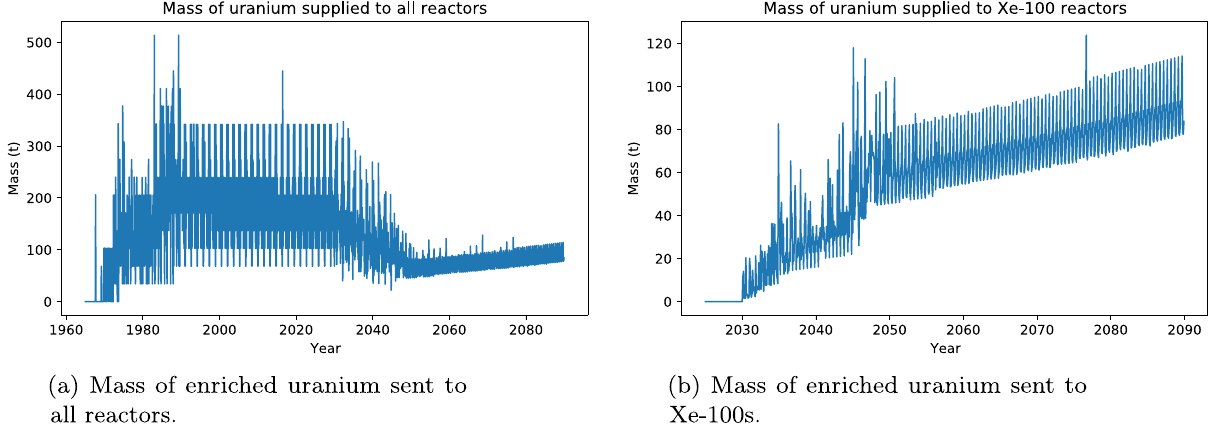
Fig. 15. Enriched uranium mass sent to reactors in Scenario 5.